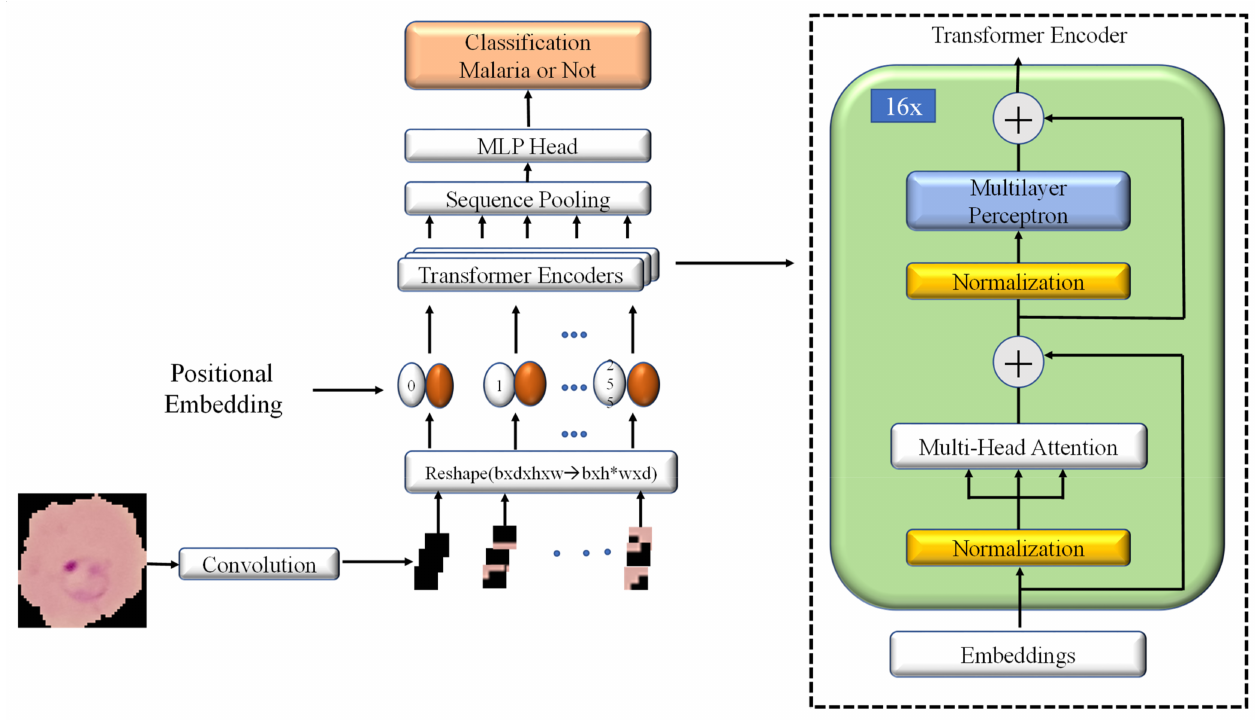
Figure 3. Compact convolutional transformer (CCT) model